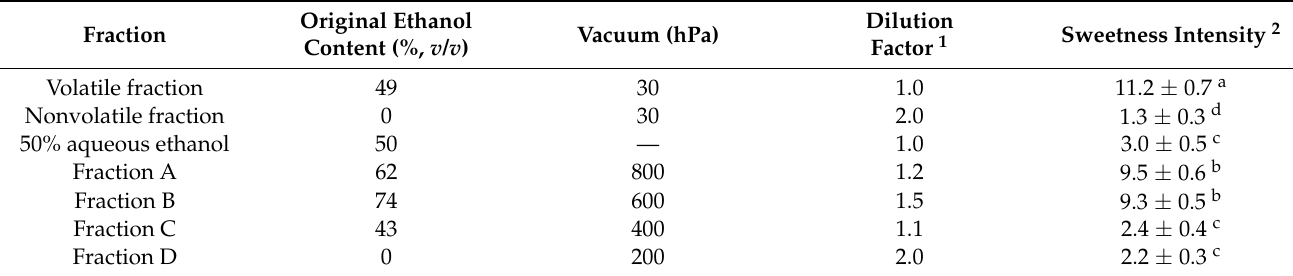
Table 1. Sweetness intensity of the fractions prepared from Baijiu sample S1.